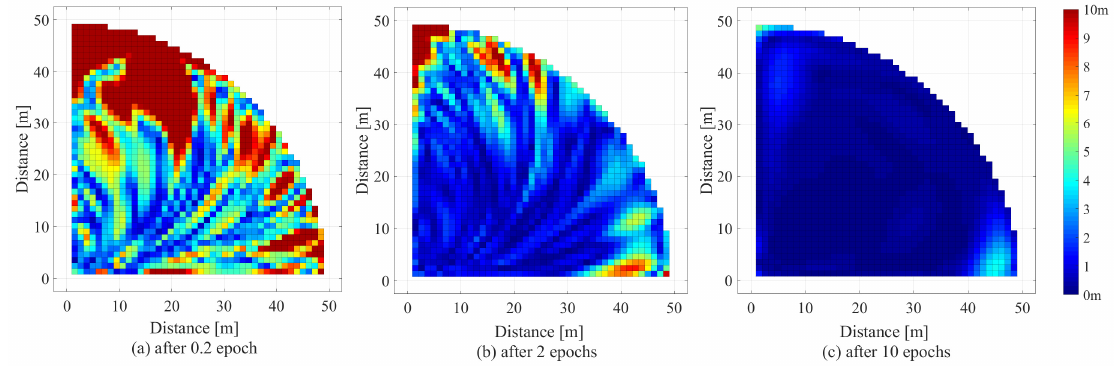
Figure 3. Location error representation of the trained DNN with respect to